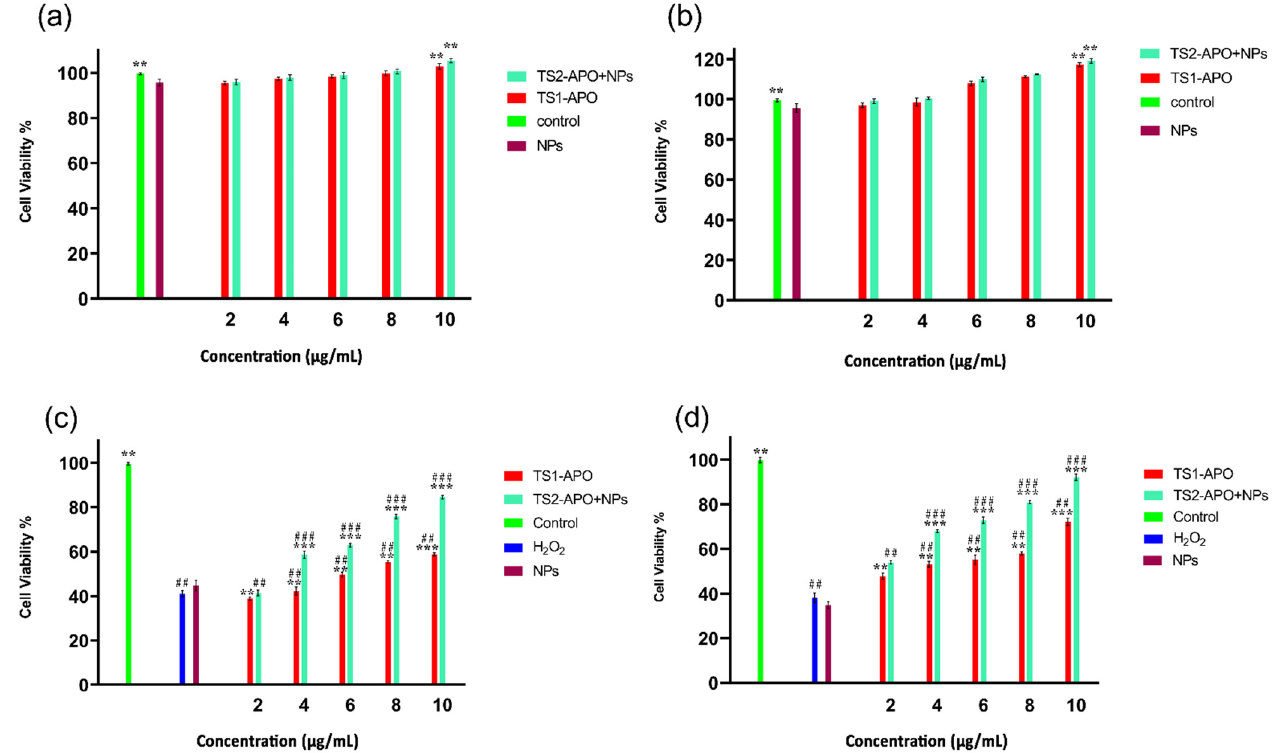
Figure 7. ( a , b ): Depicting comparative effect of APO-NPs on cell viability (%) against APO and the control at 12 and 24 h, respectively. Data is expressed in terms of mean ± SEM ( n = 3 ), significant changes are given as ** p < 0.05 and *** p < 0.01 as compared to APO and control. The graph represented that APO-NPs showed better cell viability than the other comparative groups. However, ( c , d ) showed the comparative therapeutic effects of APO-NPs on cell viability (%) against hydrogen peroxide (H 2 O 2) induced neural stress condition in the PC12 cell line. Data is expressed in terms of mean ± SEM ( n = 3 ), significant changes are given as ** p < 0.05 and *** p < 0.01, as compared to the control and APO; ## p < 0.05 and ### p < 0.01 compared to H 2 O 2 treated groups. The graph here exhibited more significant recovery than the other comparative groups. Abbreviations: APO = Apocynin pure compound; APO-NPs = Apocynin loaded optimized chitosan—PCL nanoparticles; NPs = Only chitosan—PCL optimized nanoparticles without any compound; H 2 O 2 = Hydrogen peroxide induced cells.